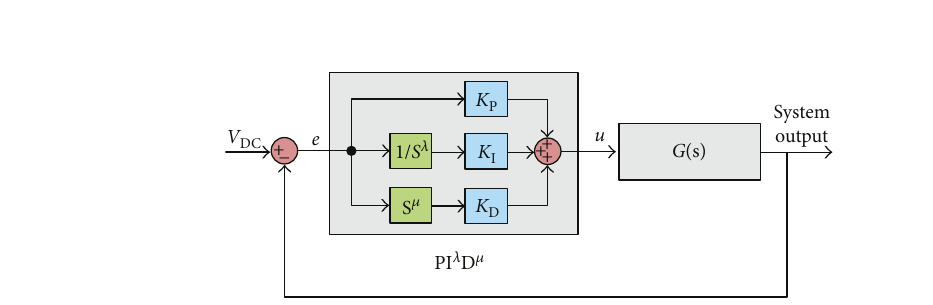
Figure 5: General block diagram of a PI λ D μ